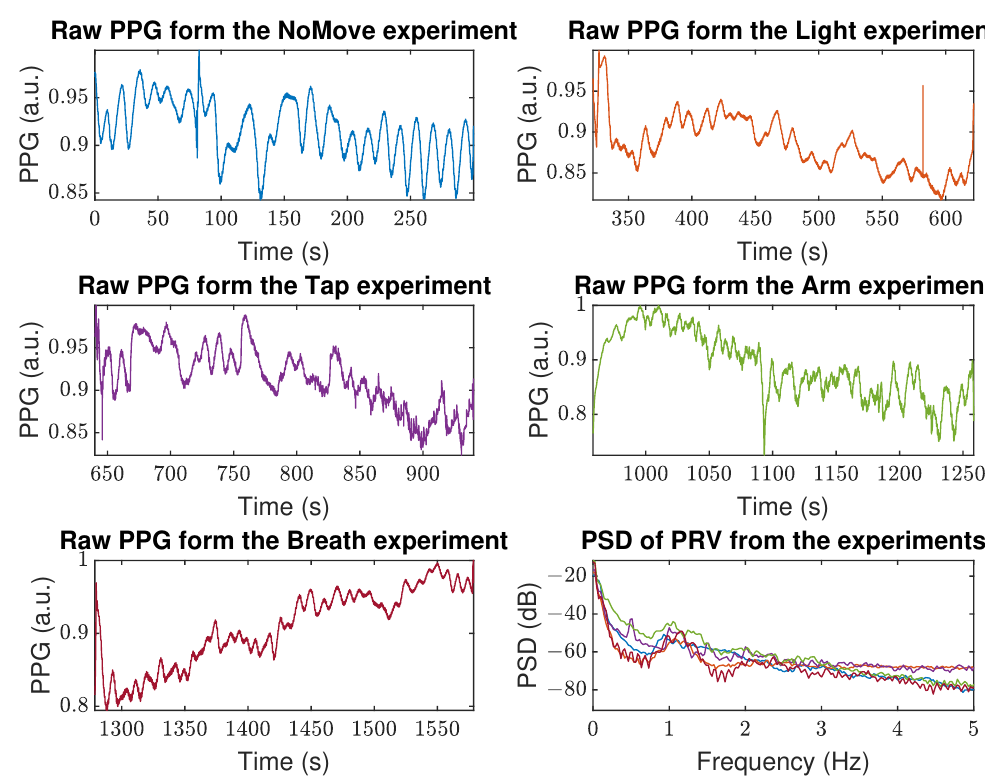
Figure 3. Raw PPG signals collected by the Samsung Watch 3 during the analyzed experiments together with their power spectral densities (PSD, lower-right panel), person P6. Colors of PPG signals are corresponding to their calculated